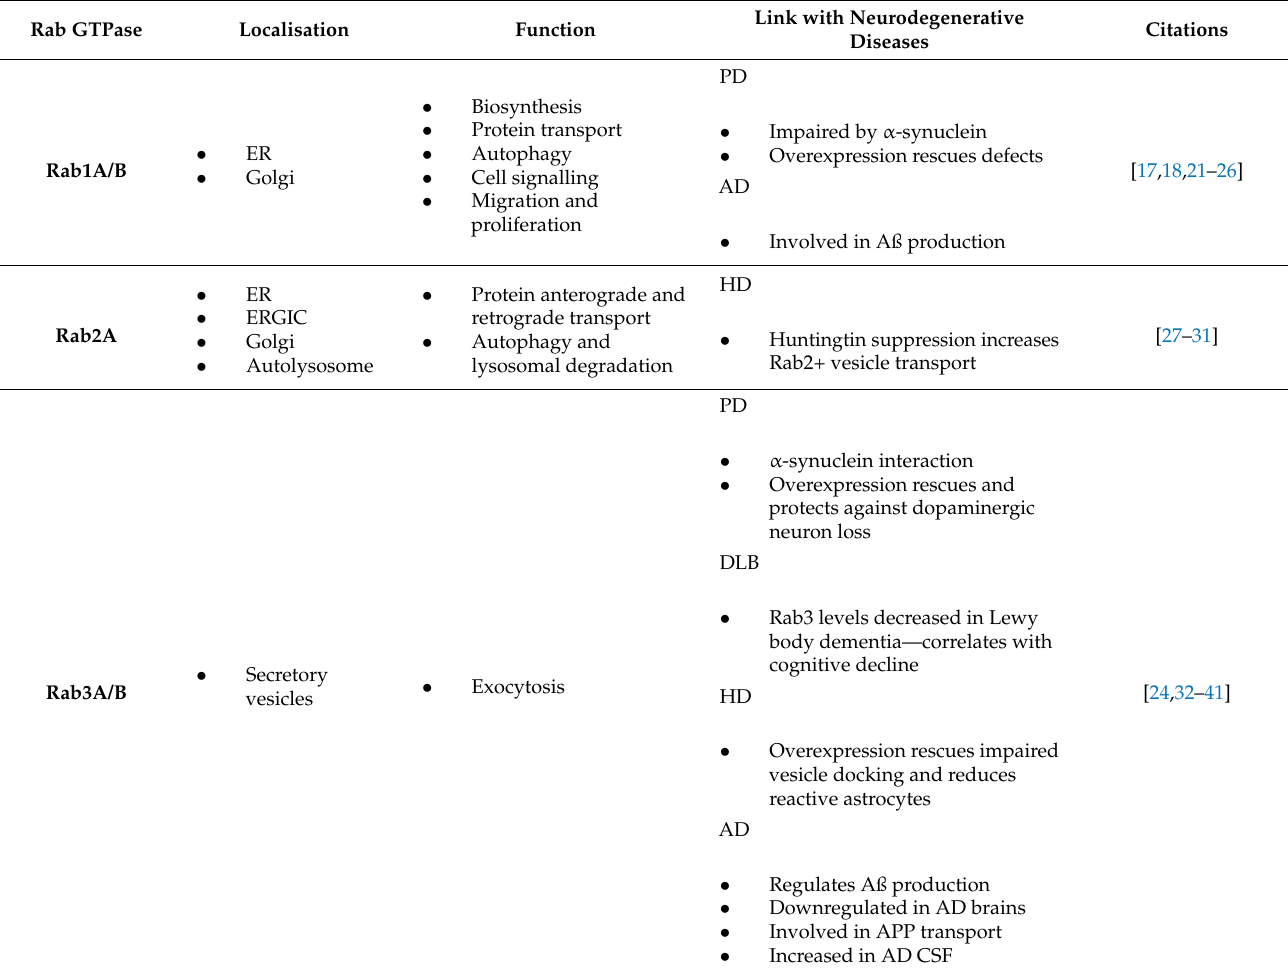
Table 1. Rab GTPases and their known localisations and functions under physiological conditions are summarised here, including their various links with Parkinson’s Disease (PD), Huntington’s Disease (HD), Dementia with Lewy Bodies (DLB), and Alzheimer’s Disease (AD). Endoplasmic reticulum (ER), trans-Golgi network (TGN), endoplasmic reticulum Golgi intermediate compartment (ERGIC), amyloid beta (Aß), amyloid precursor protein (APP), cerebral spinal fluid (CSF), knockdown (KD), huntingtin (Htt), leucine-rich repeat kinase 2 (LRRK), neurofibrillary tangles (NFT), Htt-associated protein 40